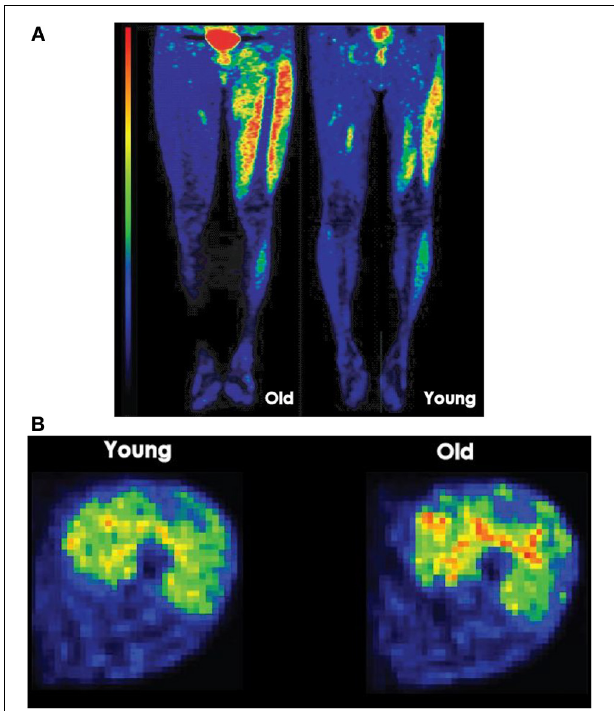
FIGURE 2 | (A) Lower limb PET images after position and force tasks. Longitudinal PET images (ventral) taken after a young and an old man performed a position task for a similar duration. The high signal intensity (red) at the center of the pelvis resulted from accumulation of [ 18 F]-FDG in the bladder. Red denotes the greatest signal intensity followed by yellow, green, and blue. (B) Glucose uptake heterogeneity in quadriceps femoris muscle during a task. Voxel-by-voxel map of relative glucose uptake in the exercising quadriceps femoris muscles of one subject. To calculate heterogeneity measure, coefficient of variation, the standard deviation of glucose uptake values in voxels of each quadriceps femoris (QF) muscle are divided by the mean glucose uptake in voxels of each QF muscle and multiplied by